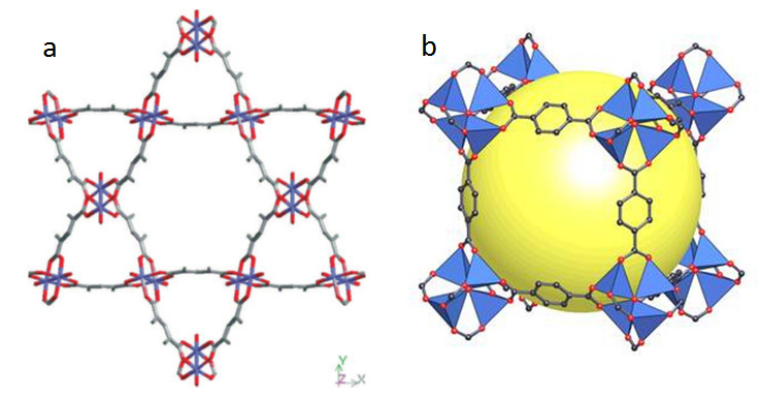
Figure 3. Remarkable MOFs: ( a ) HKUST-1, a dicopper(I) paddlewheel cluster structured by organic linkers, viewed along the cell body diagonal (111) (From [71]; reprinted with permission of AAAS) and ( b ) MOF-5, containing terephthalate anions structured by Zn clusters (reprinted from [72] with permission of Macmillan Publishers Ltd: Copyright